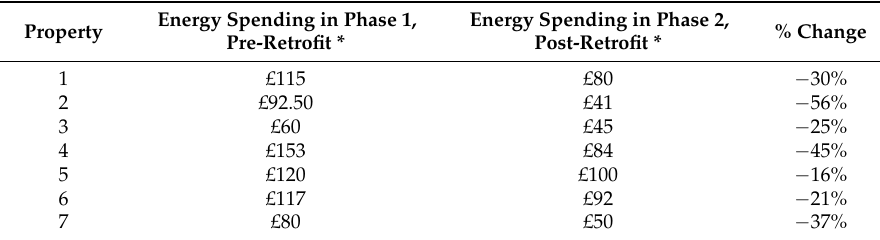
Table 1. Energy spending by household pre- and